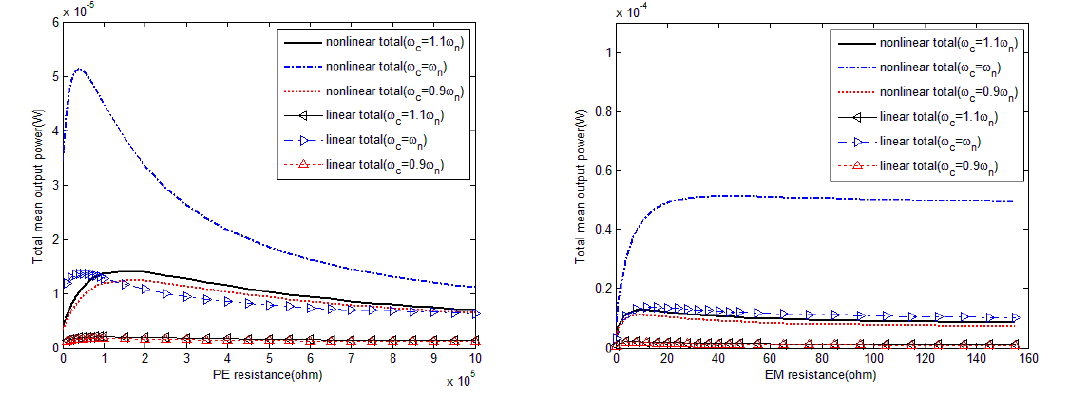
Figure 13. Total mean output power of hybrid energy harvester with load resistance under different center frequencies.